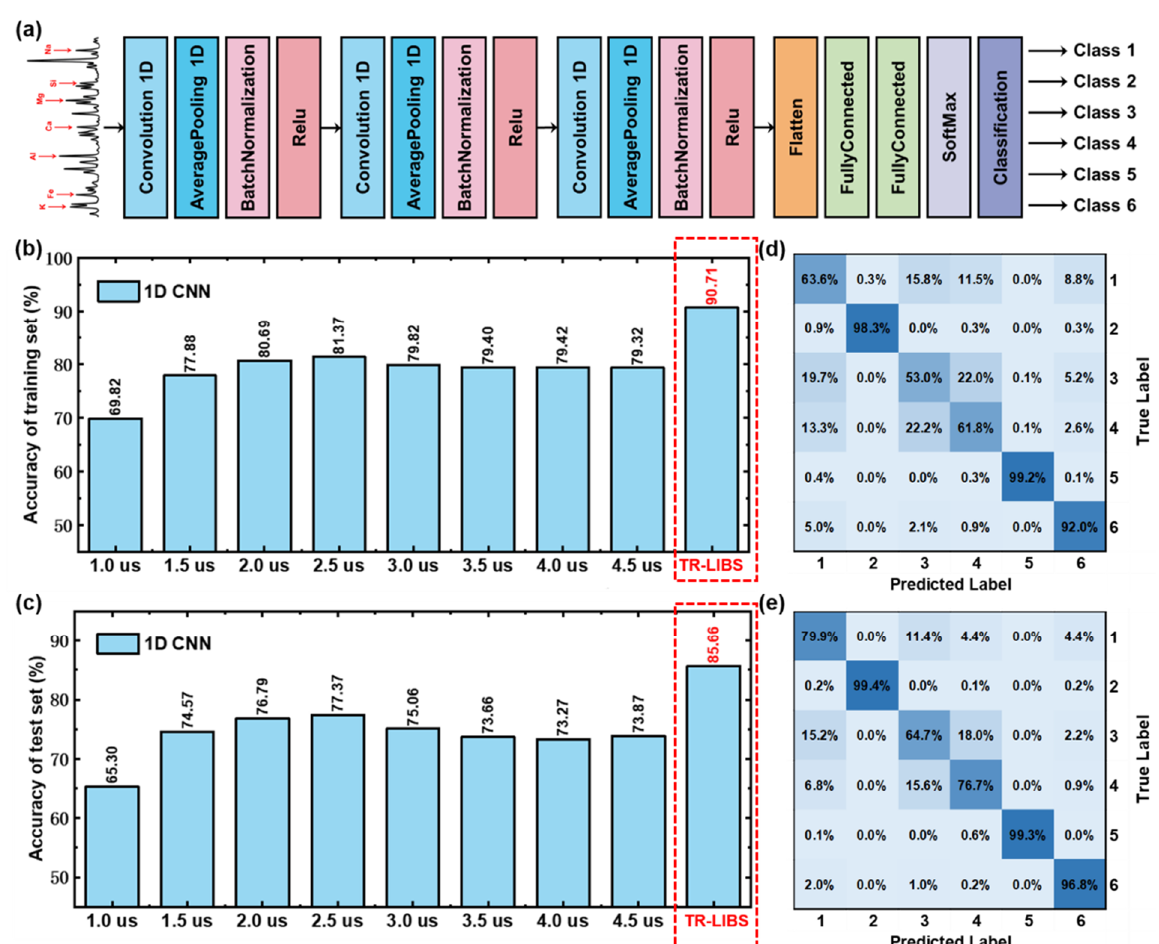
Figure 4. ( a ) Structural diagram of 1D CNN model, ( b ) training set and ( c ) test set results of 1D CNN models based on LIBS spectra and time-resolved spectra, and the test set confusion matrix of 1D CNN models based on ( d ) LIBS spectra under 2.5 μs and ( e ) time-resolved spectra. Table 2. Classification accuracy of traditional LIBS and TR-LIBS combined with machine learning models and deep learning models on the training and prediction set.